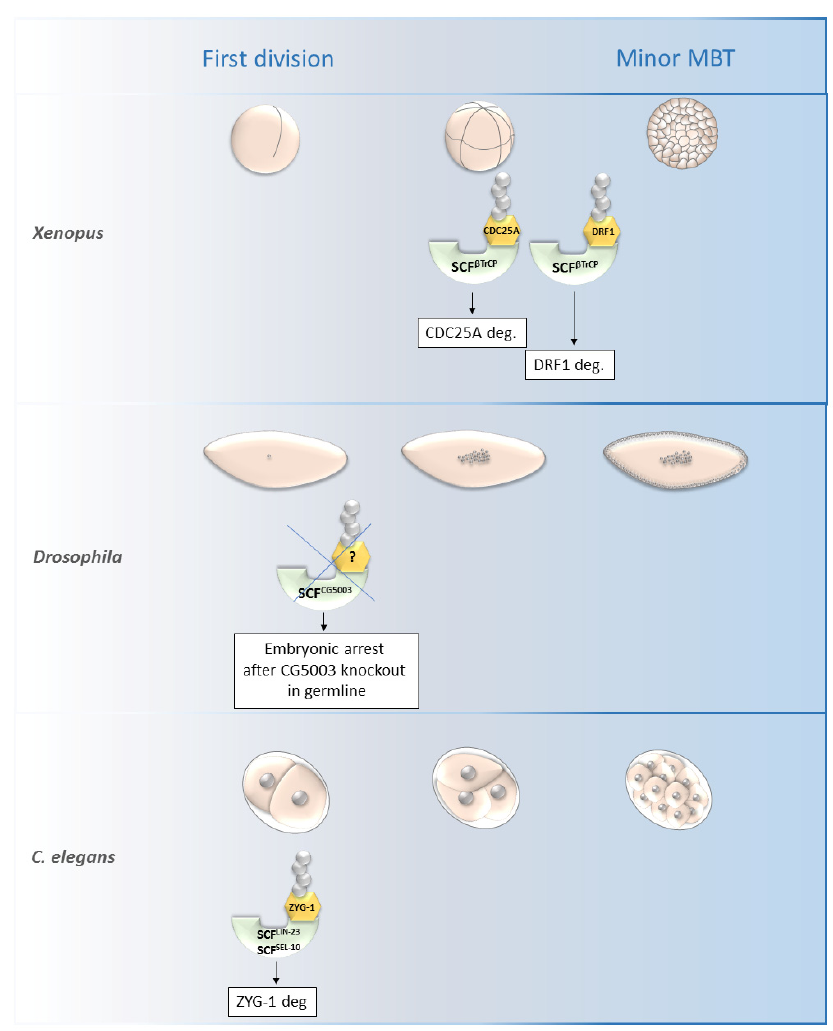
Figure 4. Roles of selected SCF ligases in embryogenesis. Figure shows selected SCF ligases and their roles in degradation of proteins during embryogenesis of Xenopus laevis, Drosophila melanogaster and C. elegans . The main impact of these selected ligases was observed from the first division until the minor MBT. The SCF β TrCP and SCF ZYG-1 - mediated degradation is important for early embryonic development of Xenopus and C. elegans, respectively. The specific substrate of SCF CG5003 in Drosophila development has not been described yet but its degradation via CG5003 is necessary for progression through the first and second embryonic division. MBT—mid-blastula transition, SCF—Skp1-Cul1-F-box complex, ZYG-1—zygote defective protein, CDC25A—M-phase inducer phosphatase